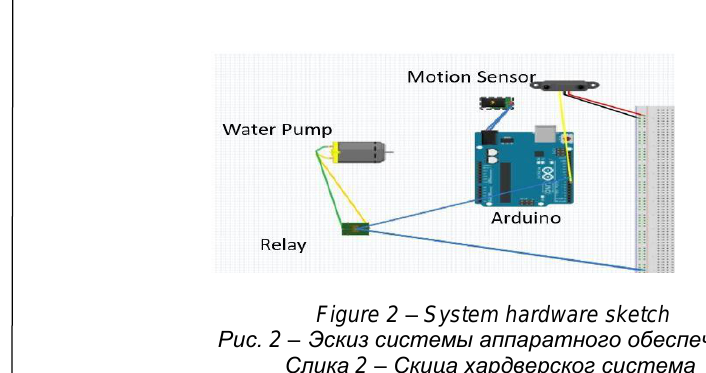
Figure 1 – Existing system of a smart sterilizer Рис. 1 – Существующая система умного стерилизатора Слика 1 – Постојећи систем паметног стерилизатора